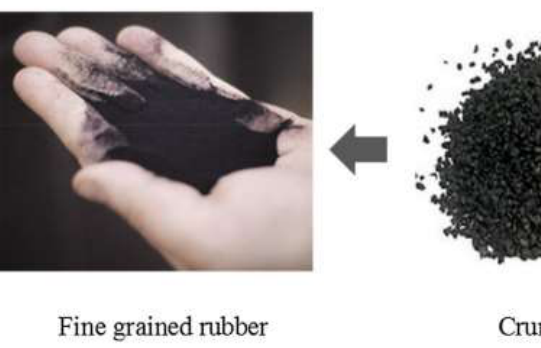
Figure 3. Different stages of tire shredding [22].